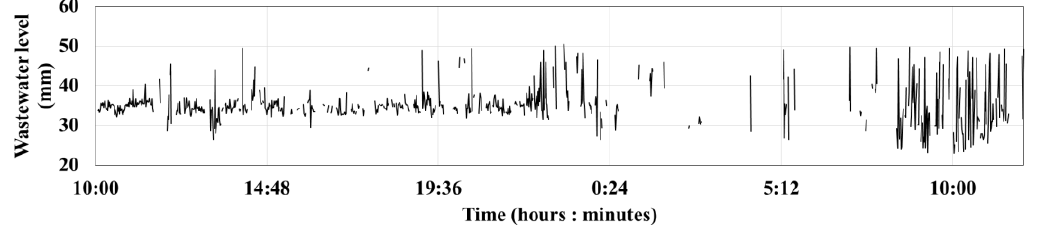
Figure 6. Wastewater level determined using method 1.